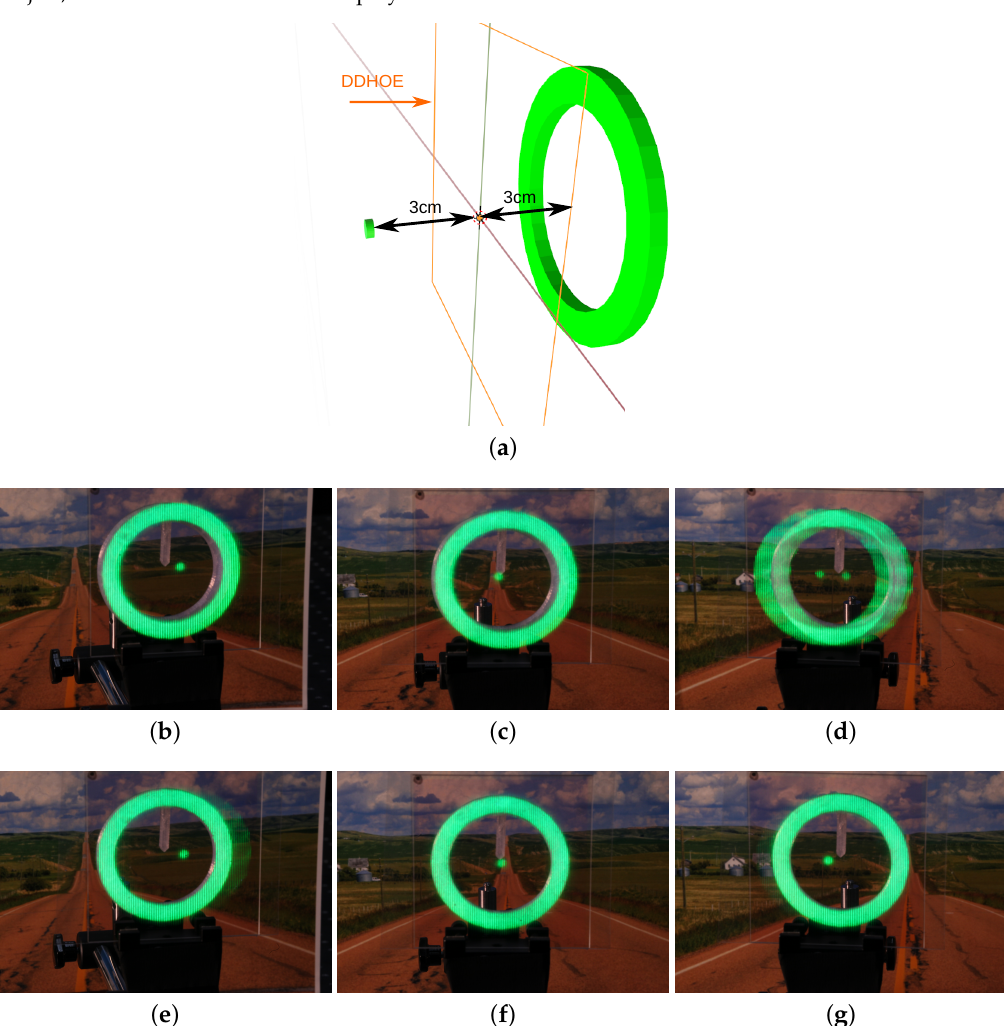
Figure 8. Alignment with of a virtual scene ( a ) with 3D-printed object: both circles should align. Calibration without markers: ( b ) left view, ( c ) center view and ( d ) right view. Calibration with markers: ( e ) left view, ( f ) center view and ( g ) right view. The 3D object is located 3 cm behind the DDHOE